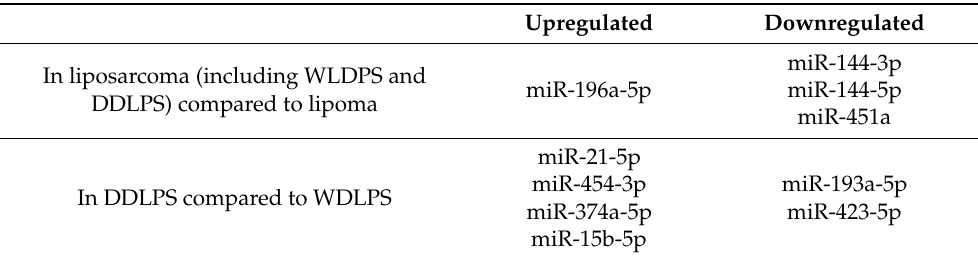
Table 2. List of most differentially expressed miRNAs in our clinical samples. Upregulated Downregulated In liposarcoma (including WLDPS and DDLPS) compared to